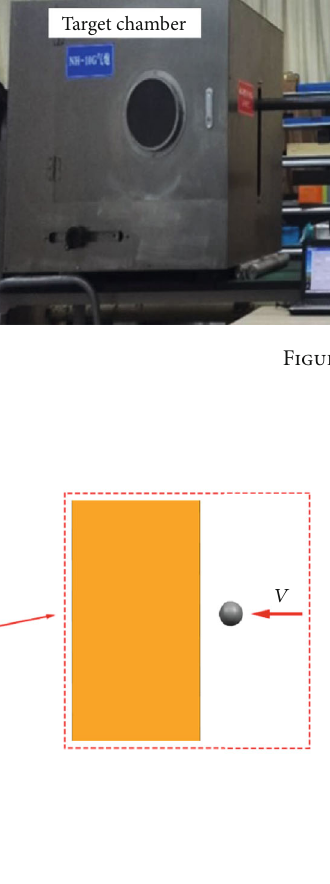
Figure 3: Impact diagram.